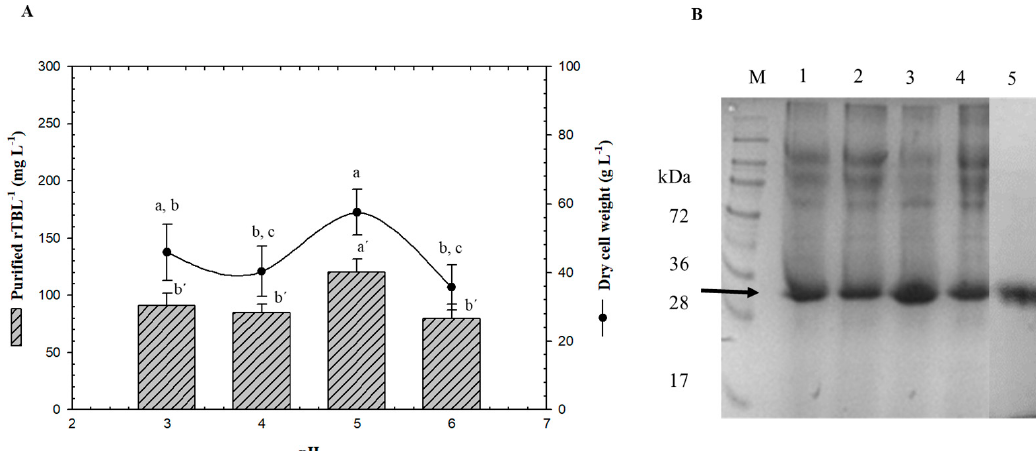
Figure 3. Effect of pH on rTBL-1 and biomass production. ( A ) Production in a batch system over 96 h with G99, ( B ) SDS-PAGE analysis of fermentation samples (96 h) at different pH. Lane 1, pH 3; lane 2, pH 4; lane 3, pH 5; lane 4, pH 6; lane 5, purified rTBL-1. M, molecular weight marker. rTBL-1 band is indicated by arrow (b). Error bars correspond to the standard deviation of three independent determinations. Different letters represent significant differences ( p ≤ 0.05; Tukey, SAS System Version 9) between treatments for wet cell weight or for rTBL ‐ 1.